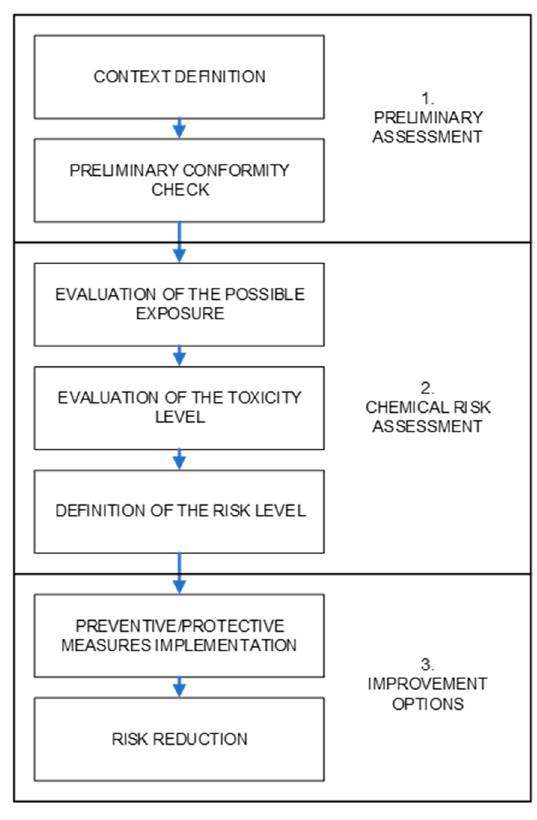
Figure 1. Scheme of the proposed approach.